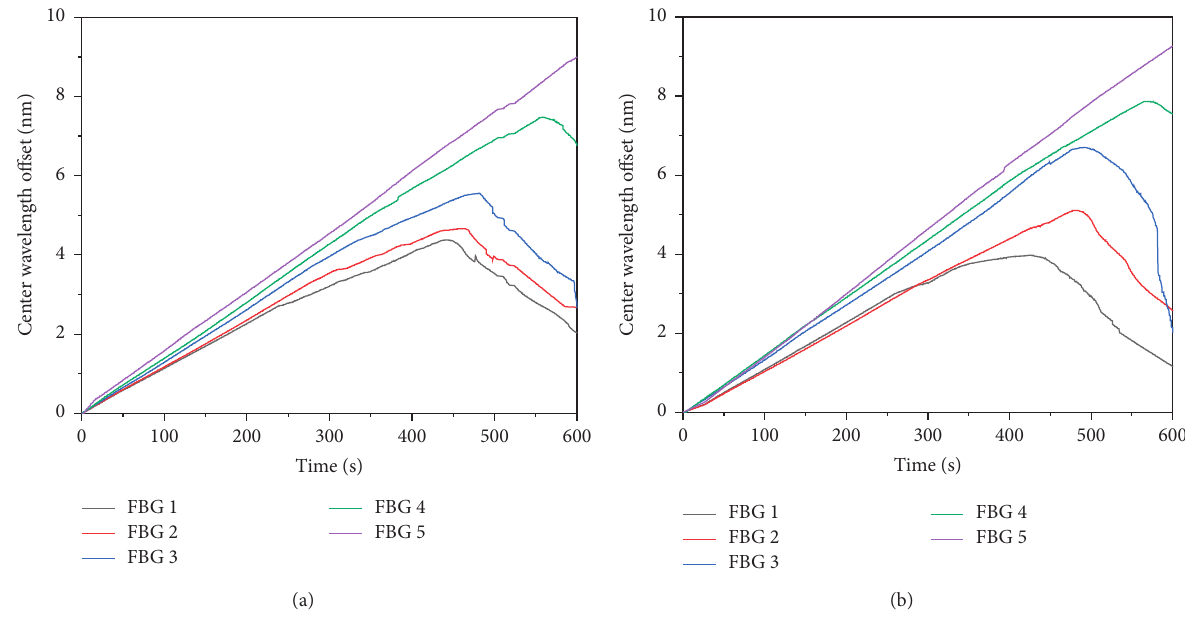
Figure 13: Curve of the offset of the central wavelength of the FBG sensor with time. (a) Measurement date of test article A. (b) Measurement date of test article B.